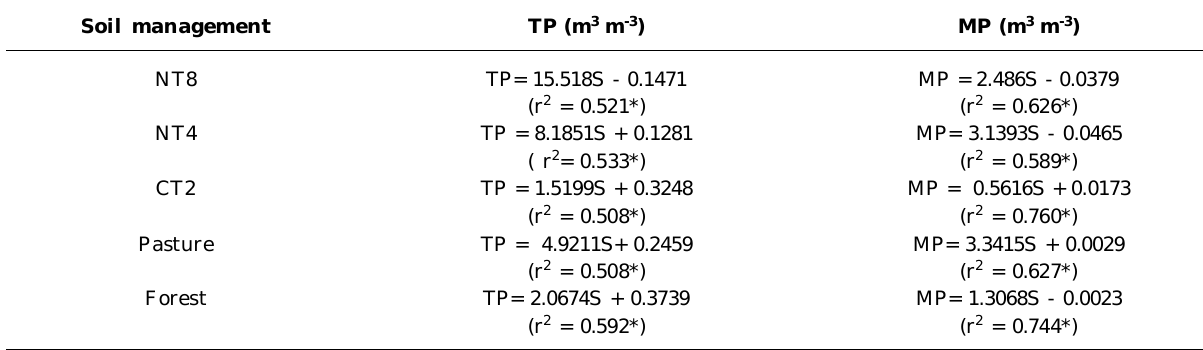
* Significant at p<0.05.